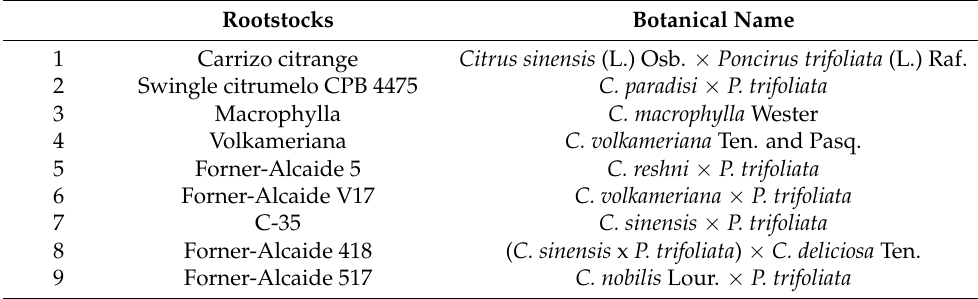
Table 1. Pedigree of the nine rootstocks tested for “Clemenules” mandarin. Rootstocks Botanical